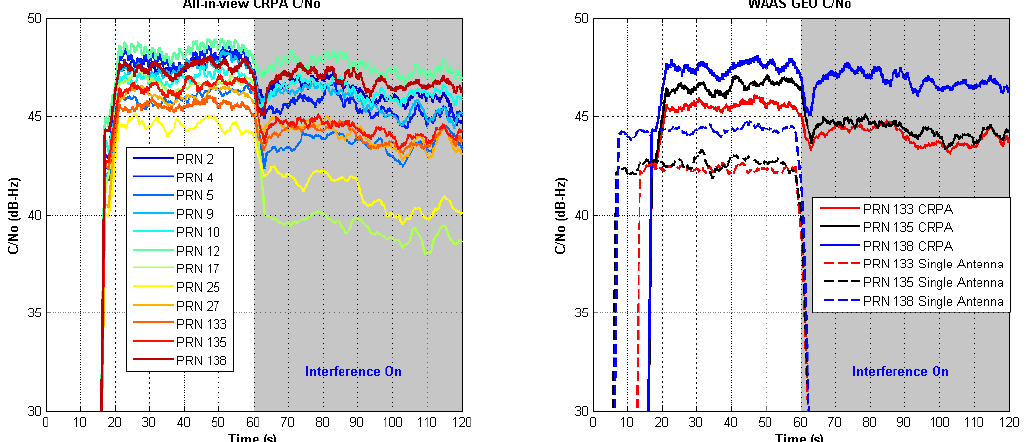
of all-in-view CRPA channels. ( right ) C/N Figure 13. ( left ) C/N 0 channels (CRPA and single antenna